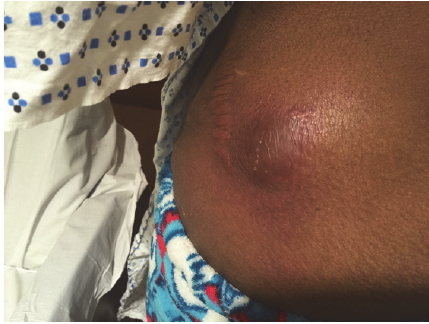
Figure 2: Soft, fluctuant, erythematous, and tender swelling in the lateral aspect of left hip.